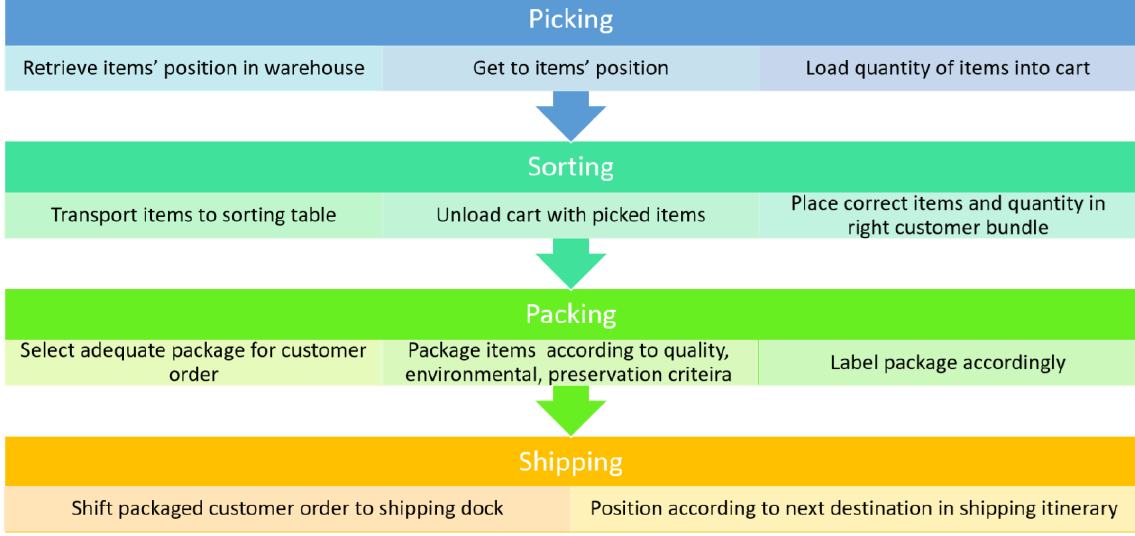
Figure 1. Warehouse outbound decomposition of activity (action and operations) (source: author).